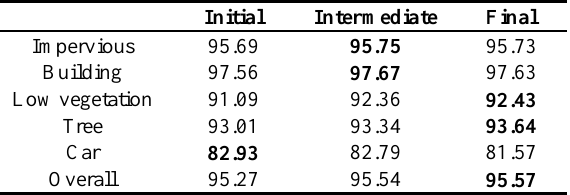
Table 1. F1 scores for each class and overall accuracies of classification results (%).